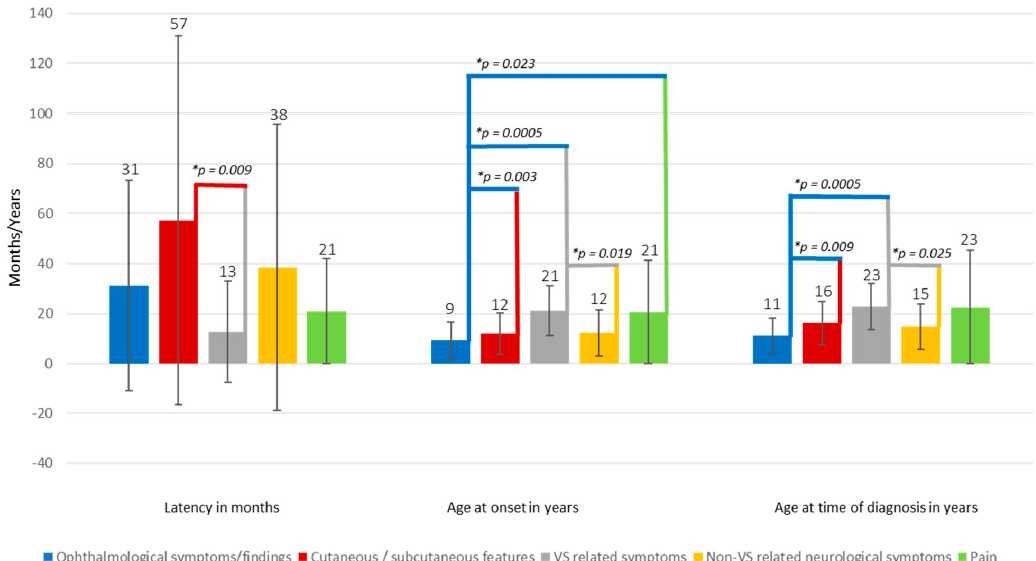
Figure 1. Age distribution of presenting symptom(s) and latency until time of diagnosis. Error bars represent the standard deviation.